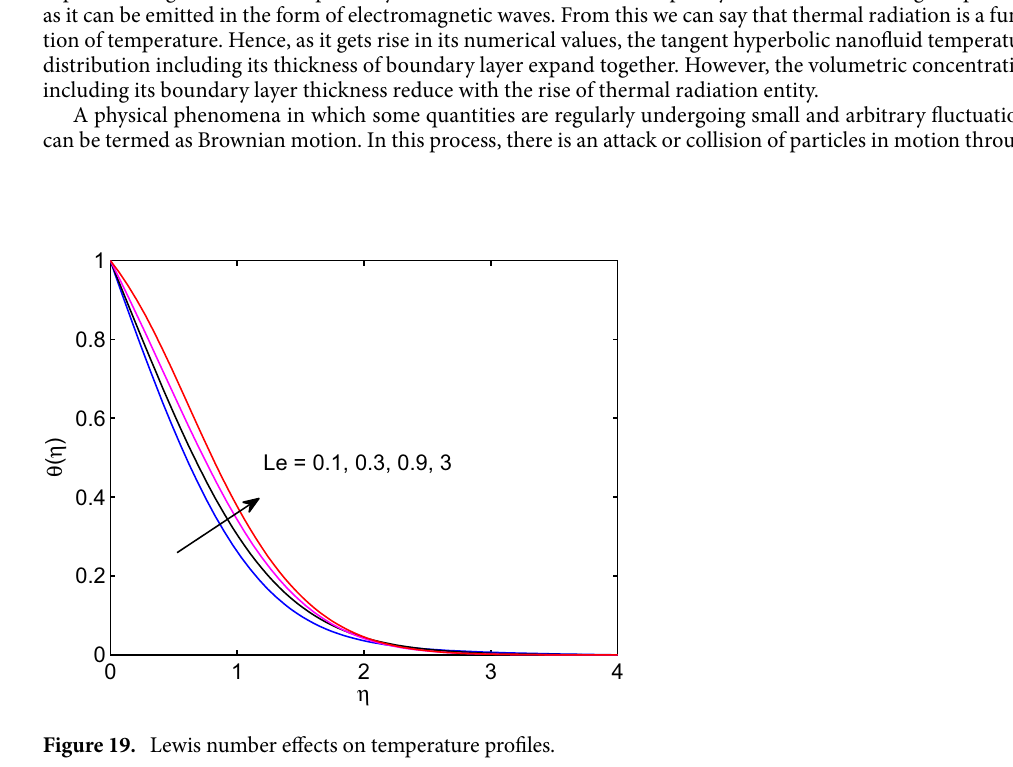
Figure 19. Lewis number effects on temperature